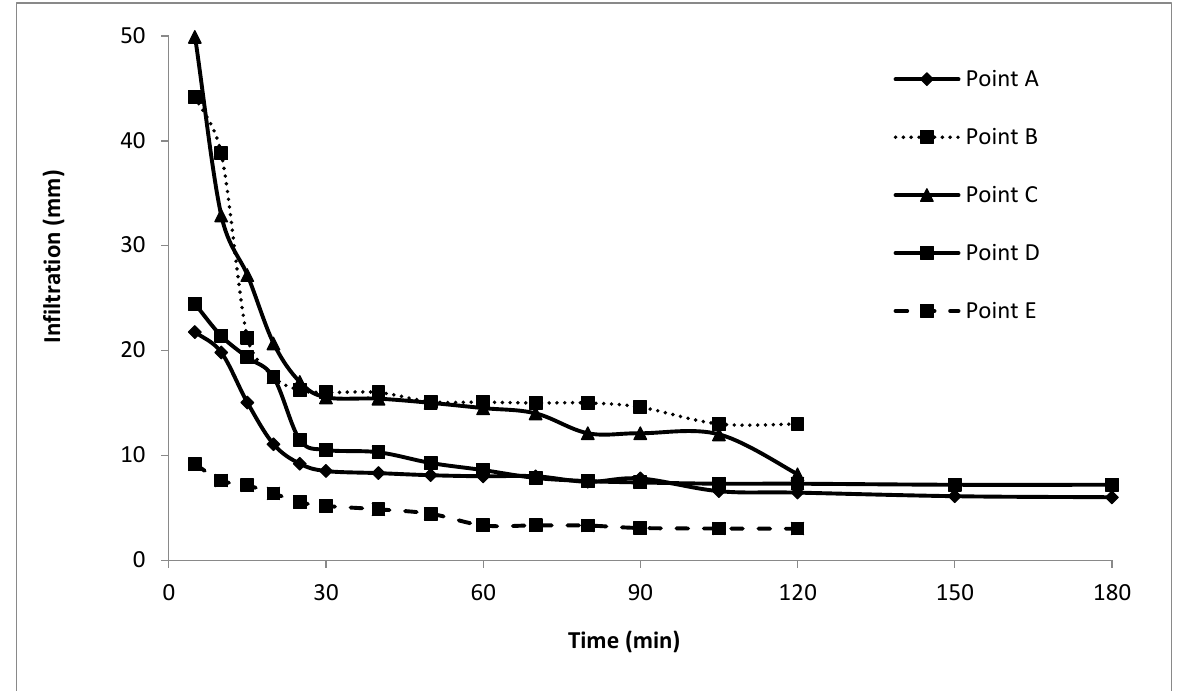
Fig. 6. Infiltration rate at three different locations in the research